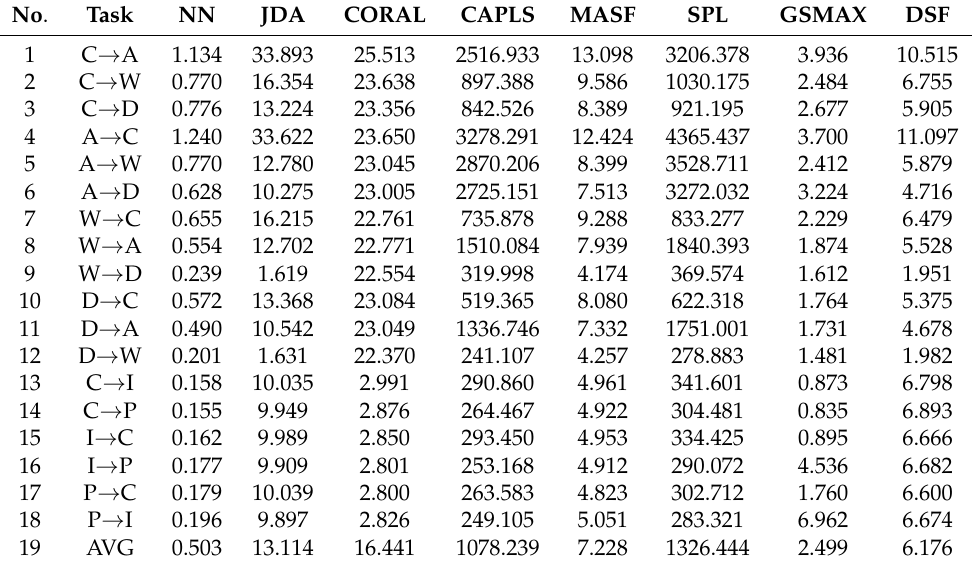
Table 5. Running time (S) on Office-Caltech10 (No.1–12) and ImageCLEF